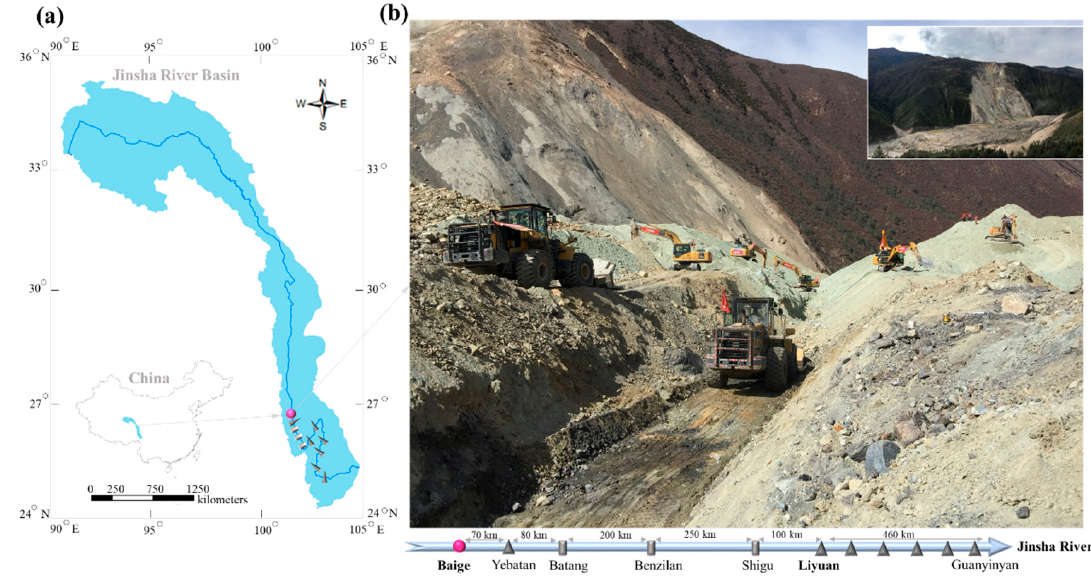
Figure 1. Location of landslide and excavation of floodgate. ( a ) Location of landslide; ( b ) workers carved out a diversion channel through the landslide blocking the Jinsha River. Baige is the place where the landslide occurred, and Yebatan is a hydropower station. Batang, Benzilan, and Shigu are hydrological stations. Liyuan and Guanyinyan are the first and the last reservoirs of the six cascade reservoirs in the midstream of the Jinsha River, respectively.